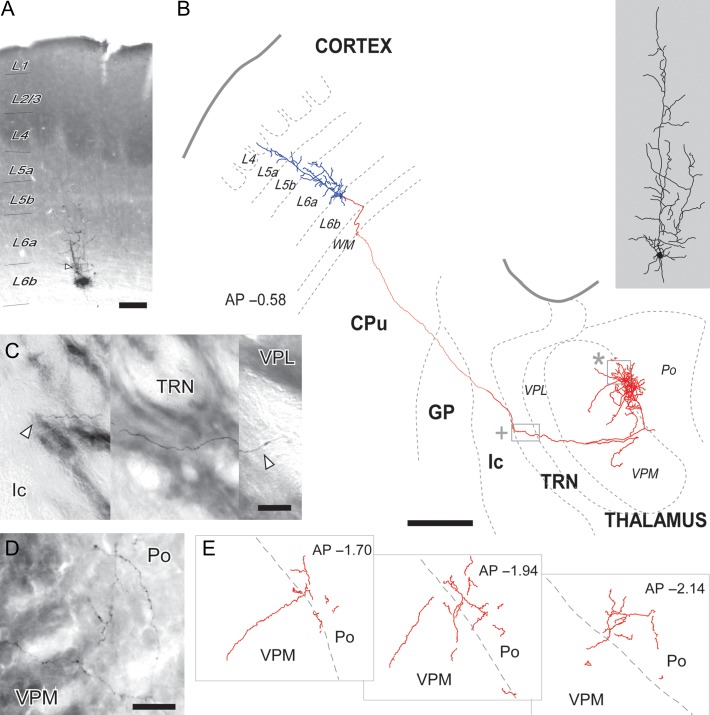
Single-cell labeling of a layer 6b neuron revealed the absence of side branches in TRN and dense innervation of lateral Po. (A) A coronal section of S1BF containing the microiontophoresis site in layer 6b (L6b). Cytochrome-oxidase counterstain revealed the barrels and Po and VPM boundary (not shown). The deposit center is visible as an amorphous black precipitate. Adjacent to it, the soma and dendrite of a labeled L6b cell (arrowhead) is visible. (B) Camera-lucida reconstruction of the somatodendritic arbor (blue) and axon (red) of the above L6b cell. The somatodendritic domain is drawn at higher magnification on the right (gray shaded area). Borders between cortical layers (L4-L6b) in cortex are delineated. AP, Distance to Bregma in the anteroposterior axis, in mm. CPu, caudate-putamen; GP, globus pallidus; Ic, internal capsule; TRN, reticular prethalamic nucleus; Po, posterior thalamic nucleus; VPL, ventral posterolateral thalamic nucleus; VPM, ventral posteromedial thalamic nucleus. (C) Photomontage showing the axon as it traverses TRN (inset in B marked by a cross). Arrowheads indicate the lateral and medial edges of Rt. (D–E) Details of the terminal axonal arbourization. In panel D, labeled segments are visible at the edge between Po and VPM (inset in B marked by an asterisk). Cytochrome-oxidase counterstain. Drawings in panel E show axon segments on several coronal levels. Scale bars: A = 150 μm; B = 500 μm; C = 25 μm; D = 50 μm.